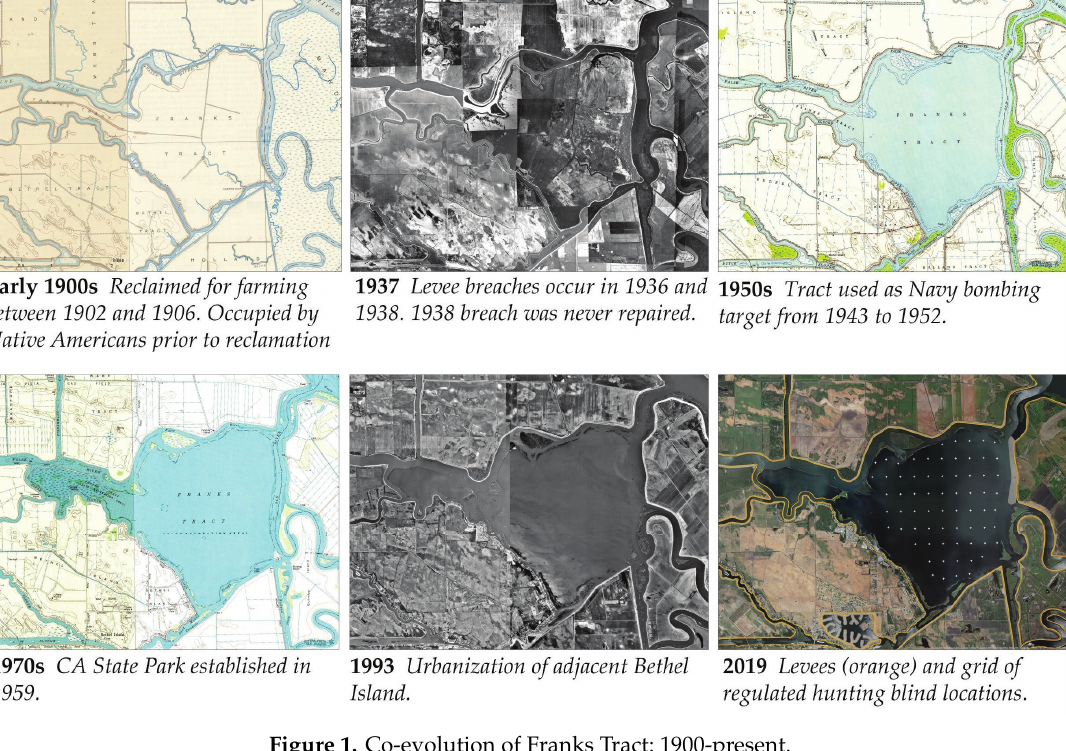
Figure 1. Co-evolution of Franks Tract: